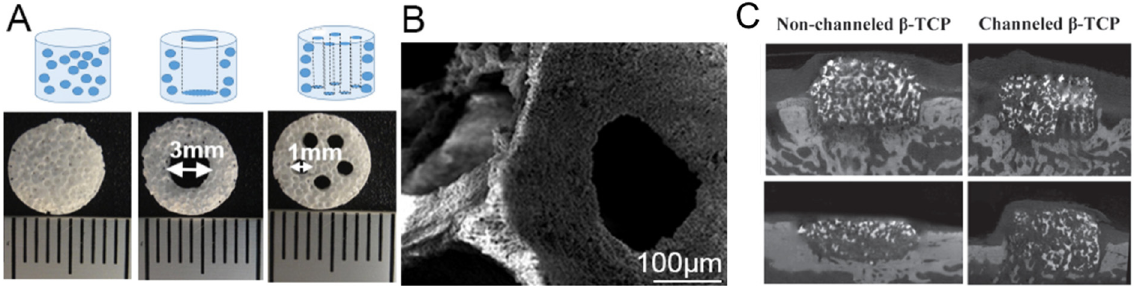
Figure 5. Schematic illustration and digital morphologies of three types of β -TCP scaffolds’ structure, ( A ) without channel, with singular 3 mm diameter channel and with five 1 mm diameter channels, ( B ) SEM image showed interconnected pores and local strut surface. Reprinted (adapted) with permission from [48]. Copyright © 2016, American Chemical Society. ( C ) Micro-CT images show that channeled scaffolds can maintain the height of regenerated bone, but scaffolds without channels degraded and lowered the height. Reprinted (adapted) with permission from [39] © 2016 WILEY-VCH Verlag GmbH & Co. KGaA, Weinheim.